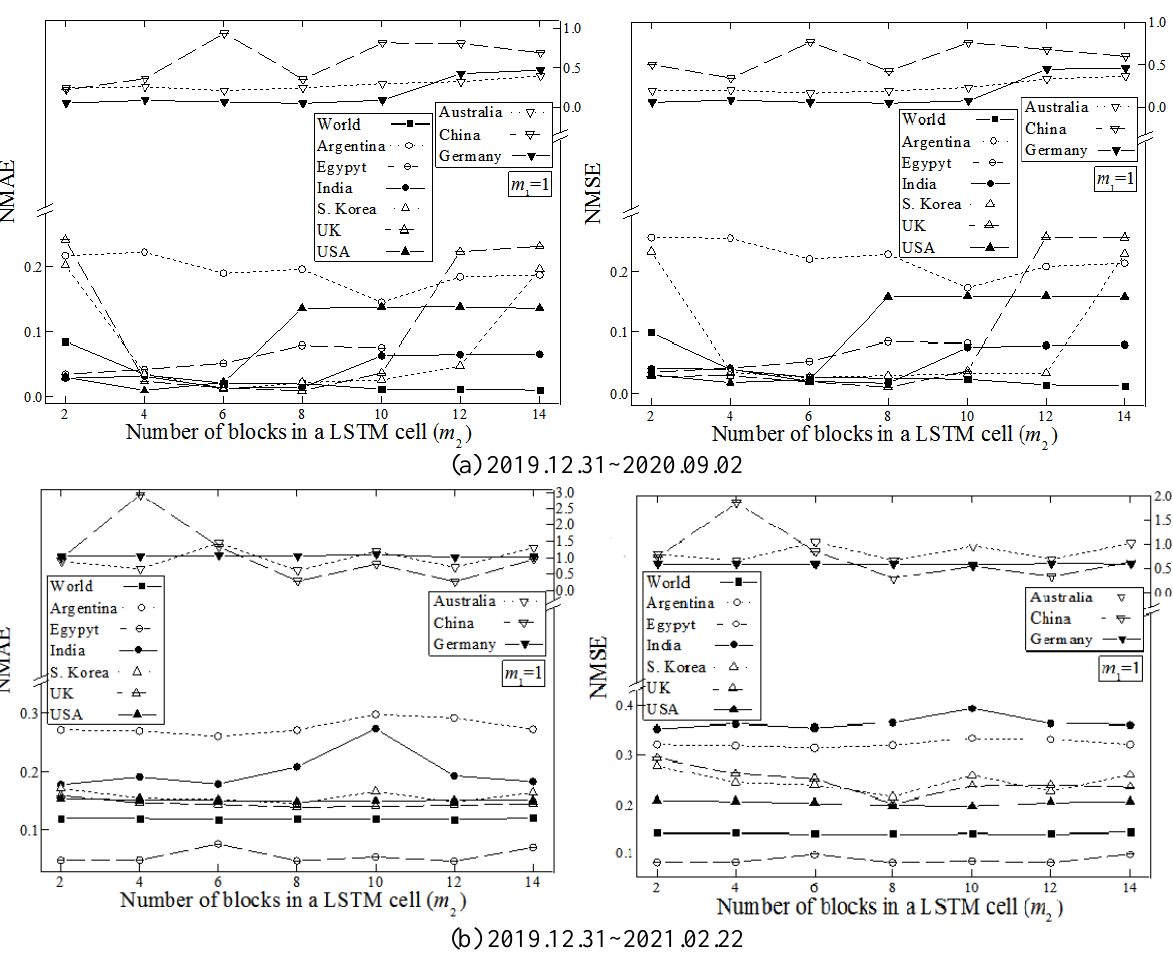
Figure 6. The performance measures values for varying number of blocks with one LSTM